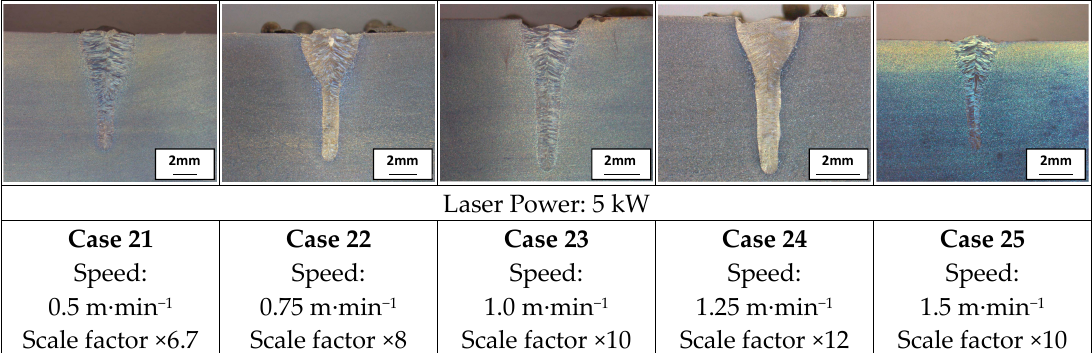
Figure 7. Bead geometry on BOP welding test (laser power: 5 kW, Case 21~25).